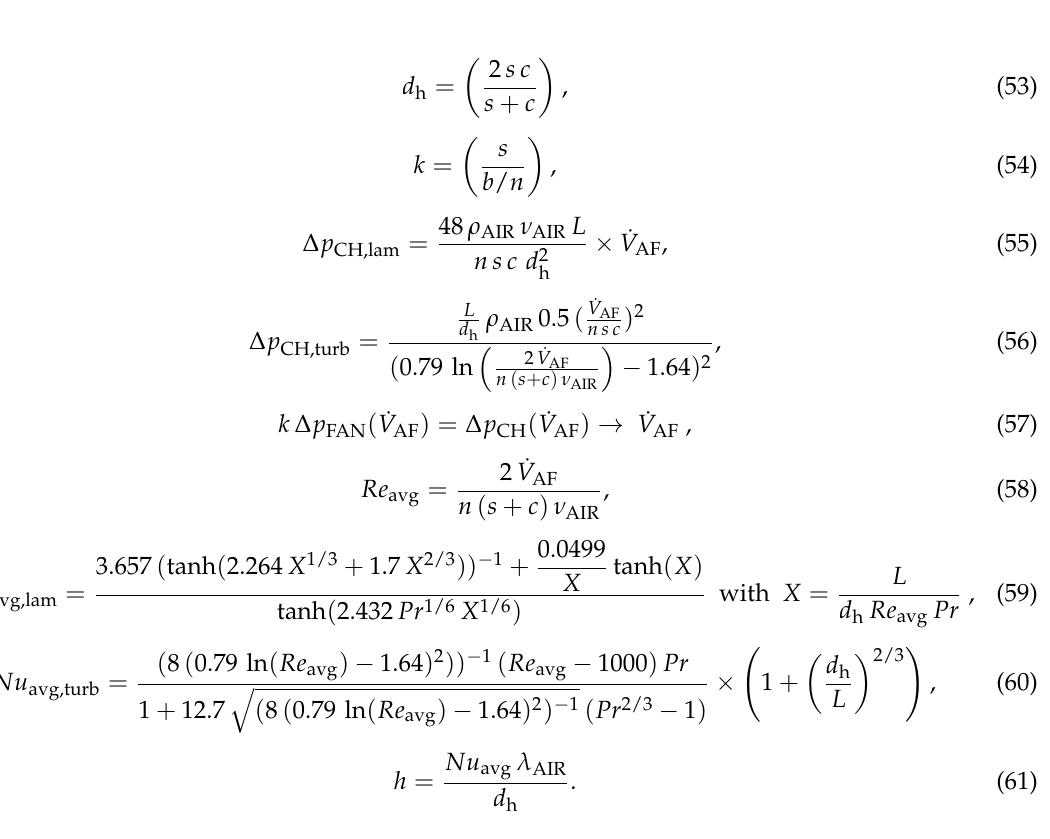
Table A4. Performance indices and parameter values that result from the optimization of the heat sink of the DAB (geometry with dual-sided base plate, cf. Figure 10). Top inset: result of the optimization, bottom inset: heat sink used in the final prototype